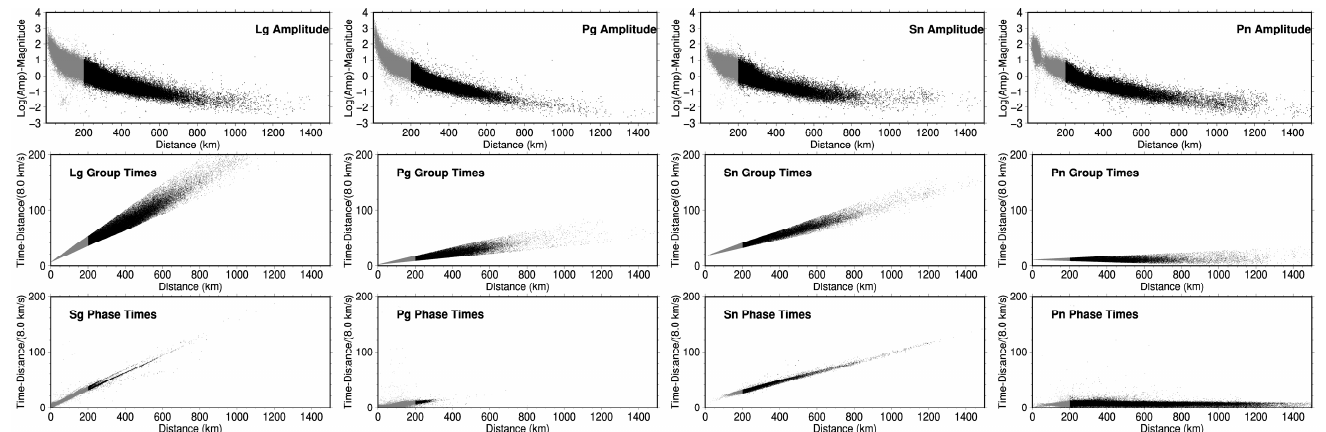
Figure 3. Raw data for travel times and amplitudes. Gray data were not used in the inversion. Amplitude and group velocity data at distances greater than 200 km were used for all four phases; Sg and Pg travel time picks for distances greater than 25 km were used; Sn and Pn travel time picks for distances greater than 100 km were used.